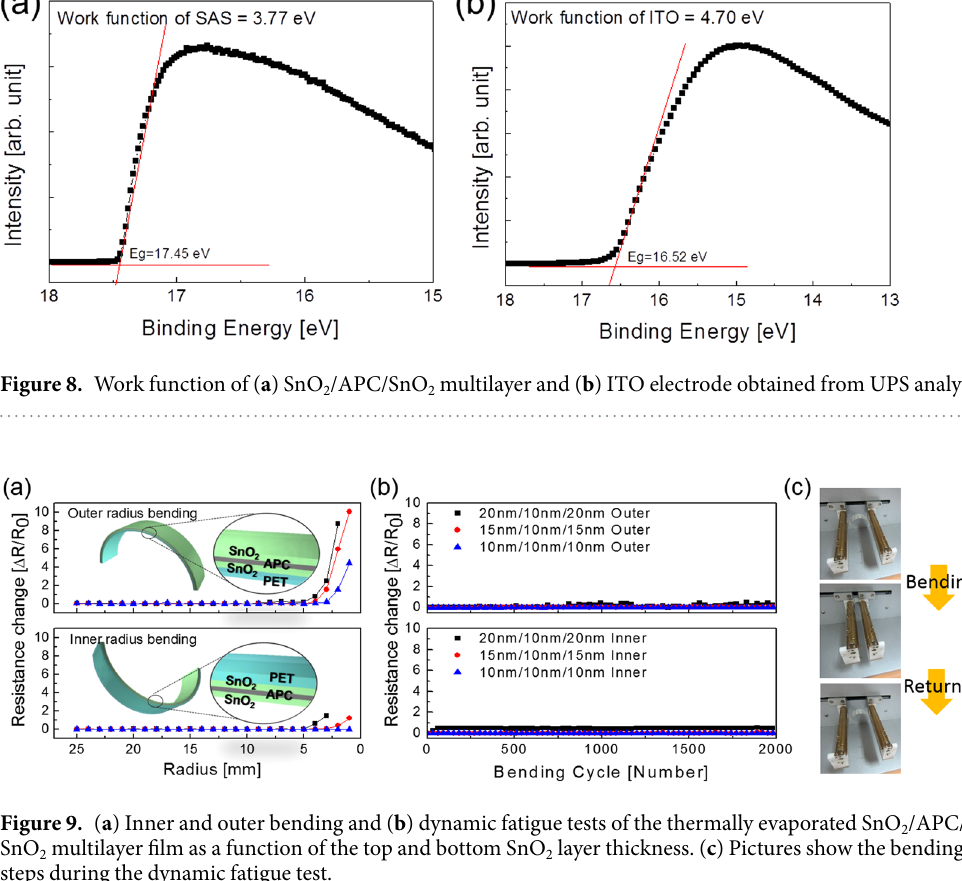
structure. However, the APC interlayer existed in a crystalline form as shown in the enlarged TEM image in Fig. 7d and the FFT pattern with bright dots. Even though the APC layer was evaporated at room temperature, it had a crystalline structure, as indicated by the arrow and inset image. The work function of the SnO 2 /APC/SnO 2 (50/10/50) multilayer was measured by ultraviolet photoelectron spectroscopy (UPS) as shown in Fig. 8. The work function ( Φ ) associated with the Fermi level ( E F ) is deter- mined by the relation, Φ = photon energy (21.22 eV) − binding energy of the secondary cutoff in the UPS spectra (Fig. 8). The work function of the SnO 2 /APC/SnO 2 multilayer (3.77 eV) was much lower than that of ITO film (4.7 eV). Therefore, the low work function of the SnO 2 /APC/SnO 2 multilayer indicates the possibility of the SnO 2 / APC/SnO 2 layer as an electron injection electrode (cathode) for transparent organic light emitting diodes. The mechanical flexibility of the thermally evaporated SnO 2 /APC/SnO 2 multilayer film was investigated by a lab-designed inner and outer bending test system. Figure 9a shows the results of the outer/inner bending tests for the SnO 2 /APC/SnO 2 multilayer electrodes with decreasing outer/inner bending radii. At a constant APC thickness of 10 nm, we varied the top and bottom SnO 2 layer thickness from 10 to 20 nm in the SnO 2 /APC/SnO 2 multilayer. Although the SnO 2 /APC/SnO 2 multilayer film with a 50 nm-thick SnO 2 layer showed the highest FOM value, considering the mechanical flexibility, the thin bottom and top layers are more favorable to the mechanical flexibility of the SnO 2 /APC/SnO 2 multilayer film. Therefore, we selected the SnO 2 /APC/SnO 2 multilayer film samples with a SnO 2 thickness below 20 nm. During substrate inner/outer bending, we measured the change of resistance ( Δ R = R − R 0 ) with decreasing bending radius, where R 0 is the initial measured resistance of the sam- ple, and R is the resistance measured under SnO 2 /APC/SnO 2 /PET bending. The outer bending test result (upper panel) shown in Fig. 9a illustrates that the SnO 2 /APC/SnO 2 multilayer film with a 20 nm-thick SnO 2 layer had a constant resistance until the bending radius reached 4 mm. Further decrease of the top and bottom SnO 2 layer thickness led to a decrease of the critical bending radius for the SnO 2 /APC/SnO 2 multilayer film to 3 and 2 mm, respectively. The following equation can be used to calculate the peak strain for a curved SnO 2 /APC/SnO 2 multi- layer film with decreasing bending radius 43 : + d d f PET = × Strain 100 (1) 2R Here, d f and d PET are the thicknesses of the SnO 2 /APC/SnO 2 multilayer film and the PET substrate, respectively. Bending the SnO 2 /APC/SnO 2 multilayer film (20 nm/10 nm/20 nm) on a 125 μ m-thick PET substrate to a bend- ing radius of 4 mm resulted in a peak strain of 1.56%. In addition, the SnO 2 /APC/SnO 2 sample with 15 and 8 Scientific RepoRts | 7: 2550 | DOI:10.1038/s41598-017-02711-2